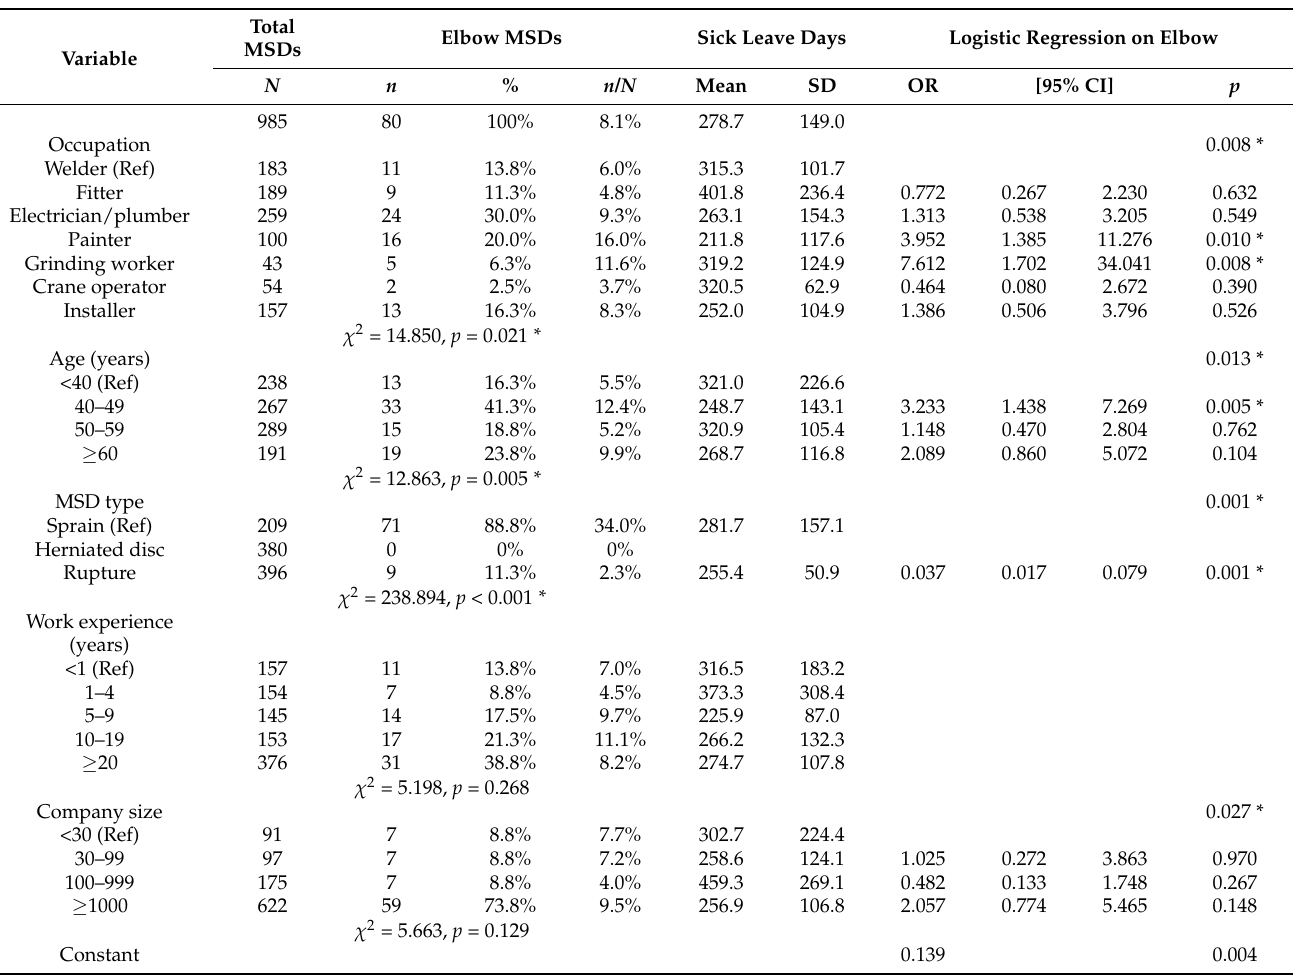
Table 5. Distribution and sick leave days of elbow MSDs and factors associated with elbow